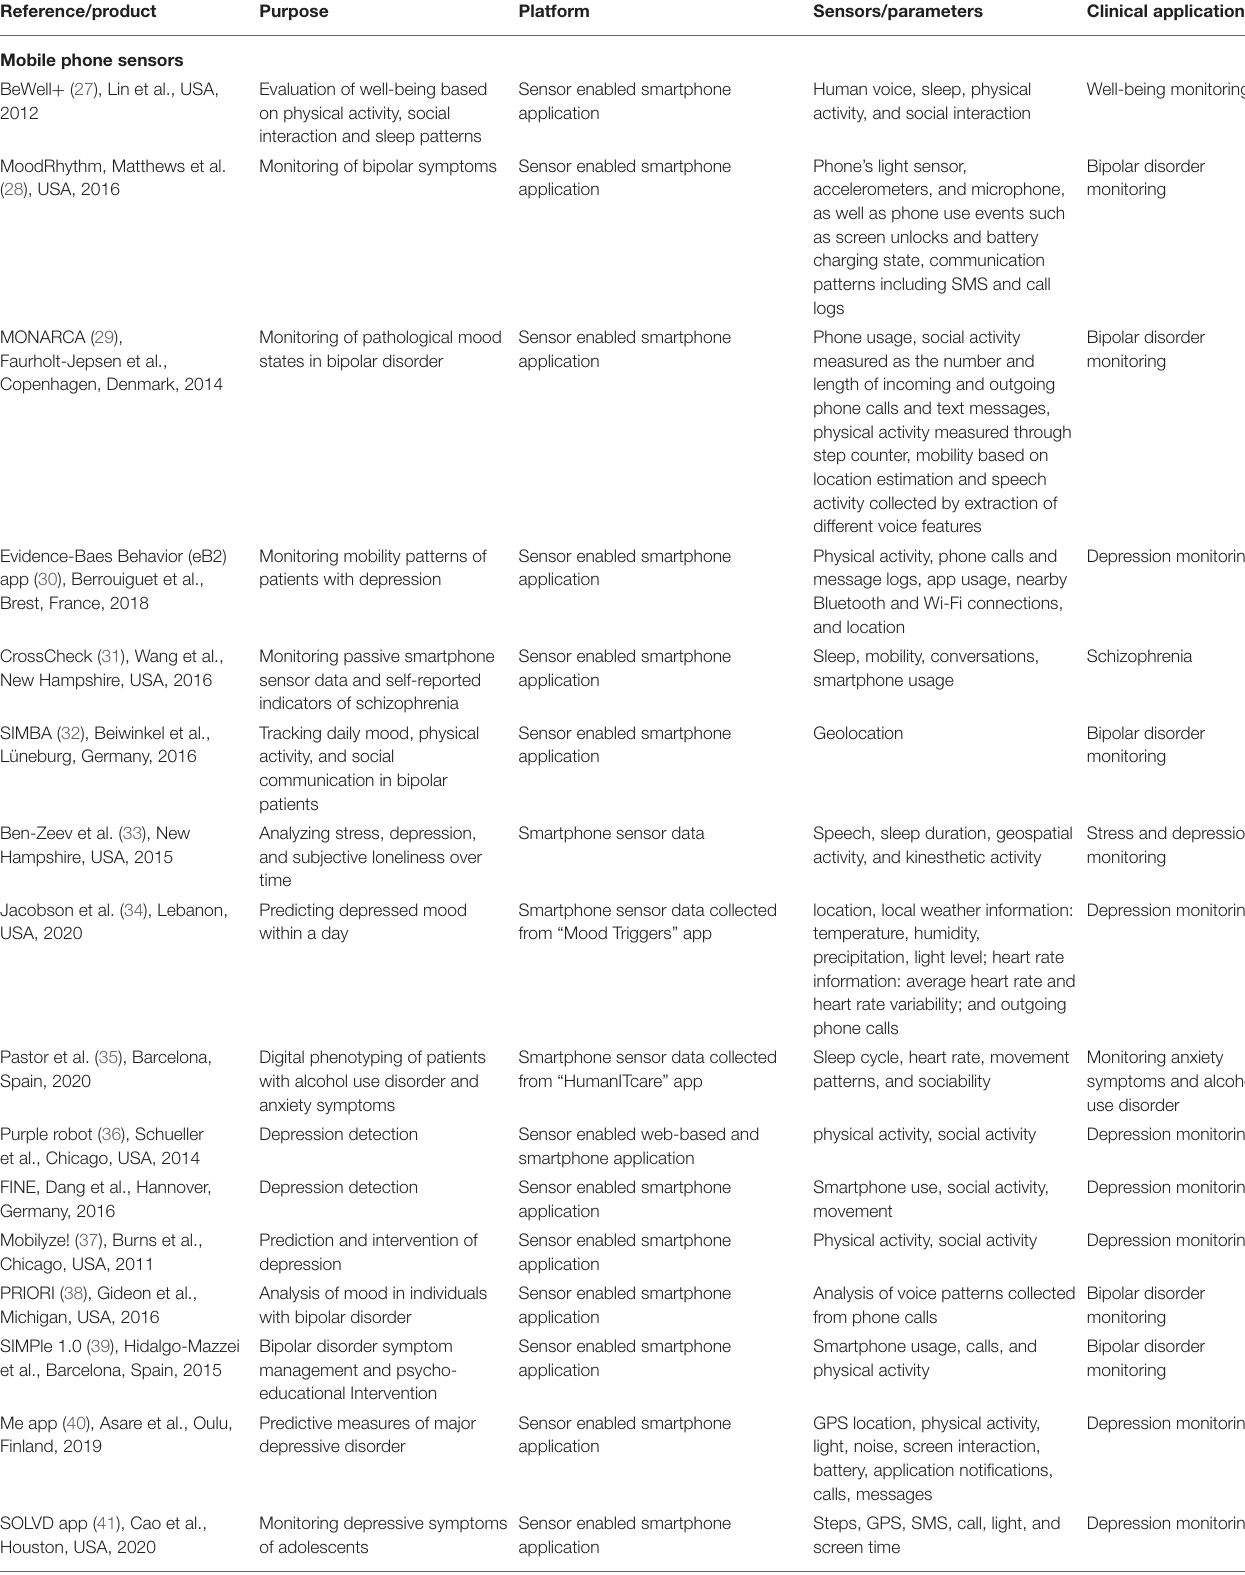
TABLE 2 | Smartphone-based physiological and emotional monitoring research